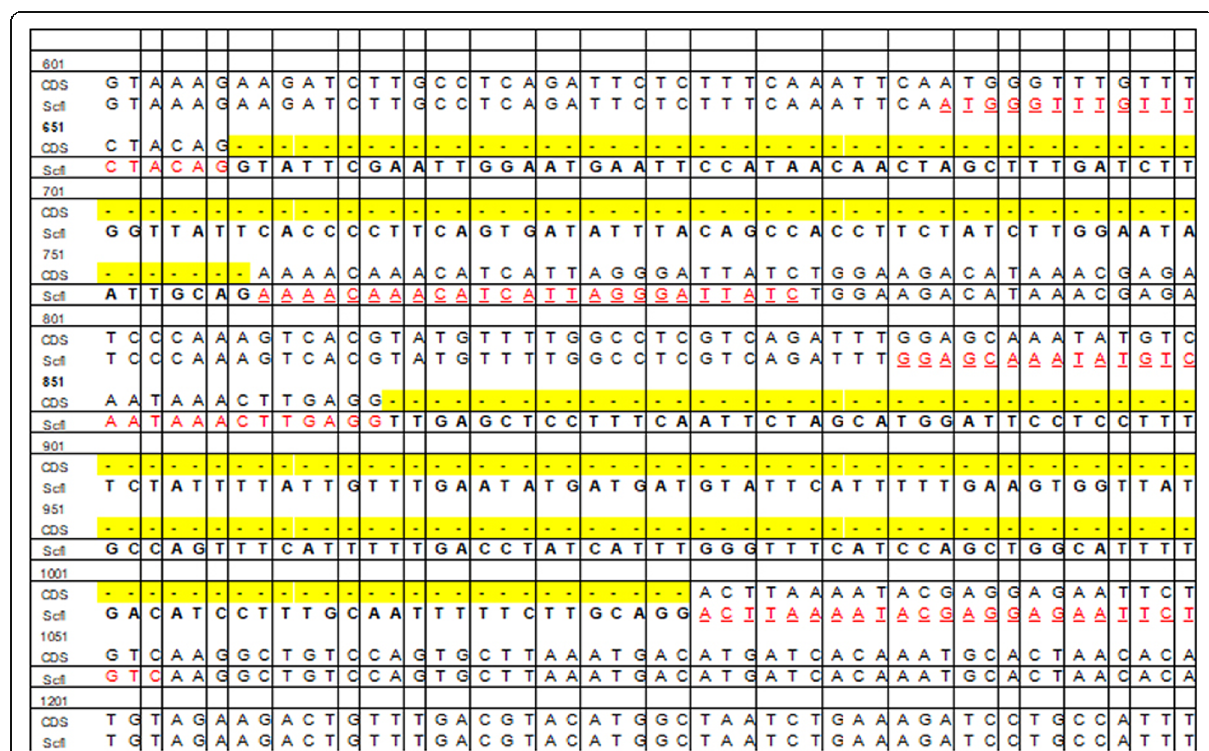
Fig. 7 Aligned CDS and scaffold representing SQS gene. Red fonts indicate primer sequences used for validation, and yellow boxes on the CDS side and counter bold sequences on the scaffold side represent introns. The first intron starts from scaffold sequence number 1827 and ends on 1927 (corresponding CDS sequence number 657 and 758 bp, respectively), and the second intron starts from scaffold sequence number 2034 and ends on 2197 (corresponding CDS sequence number 864 and 1027 bp, respectively)